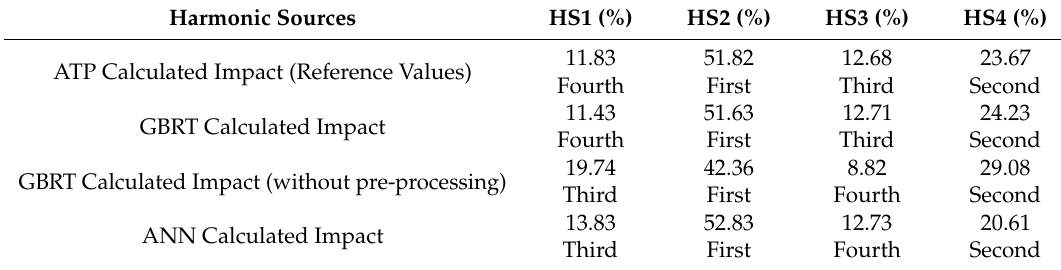
Table 3. Impact factors calculated for each nonlinear load.